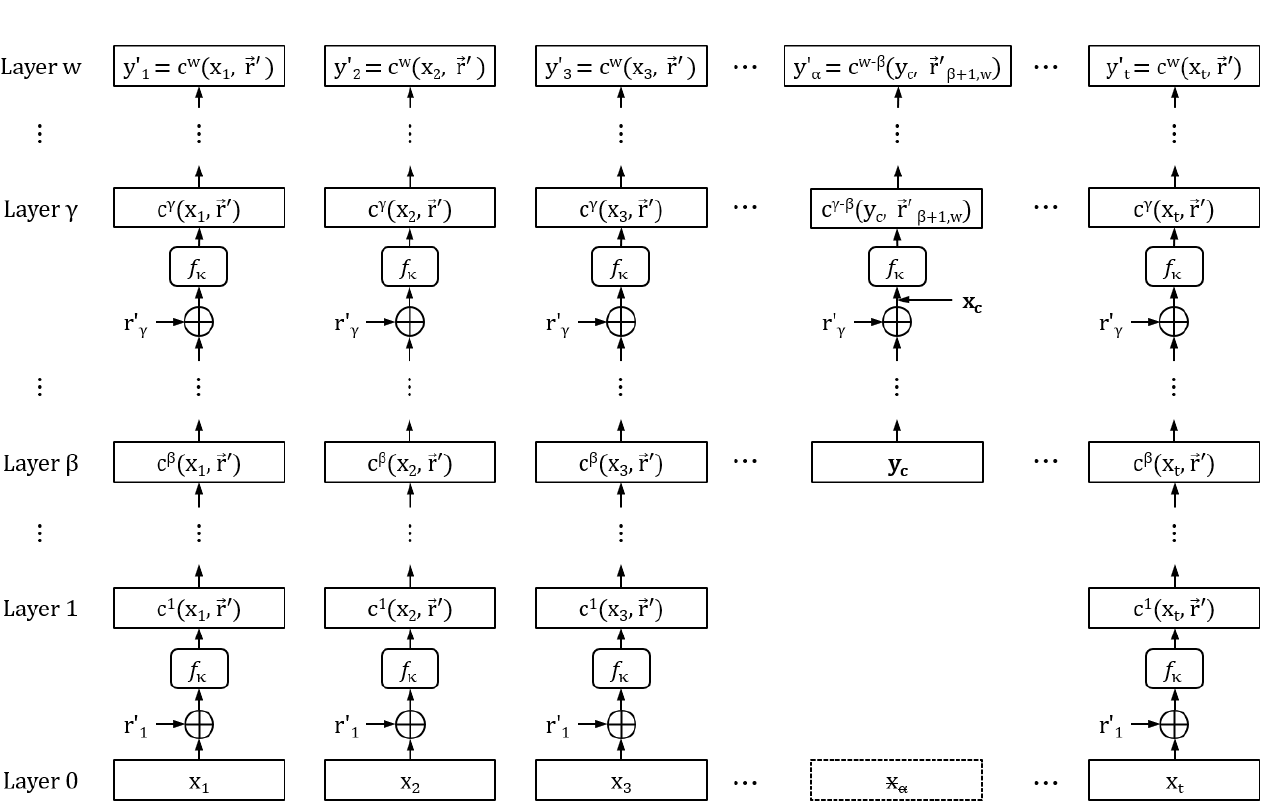
Figure A1. The basic construction of the modified public